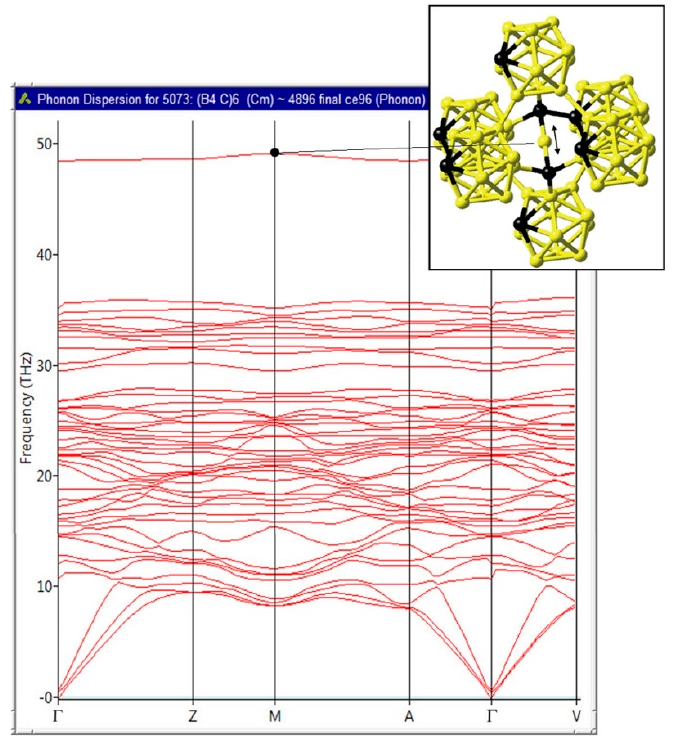
Figure 14. Phonon dispersion of B 4 C computed using the direct method (finite displacement method) as implemented in MedeA-Phonon. The high-frequency mode at 48 THz corresponds to the bond-stretching vibrational mode of the B atoms in the C-B-C linear rods as indicated by the arrow shown in the inset.